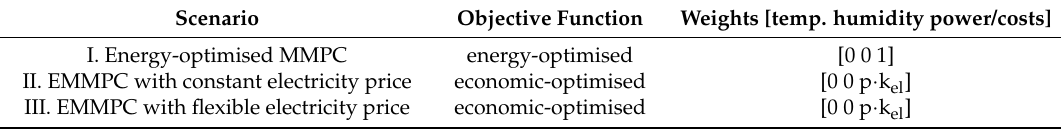
Table 2. Overview of the simulated scenarios with optimised HVAC (heating, ventilation, and air conditioning)